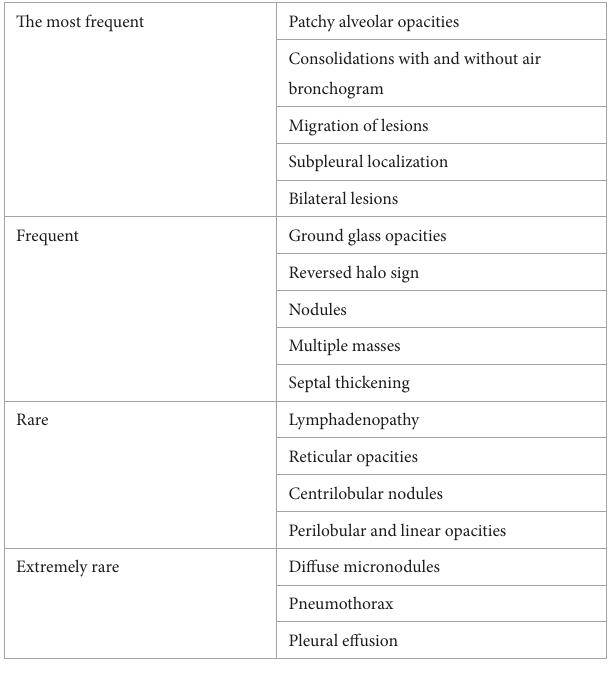
TABLE 4 Radiological findings detected in OP patients.